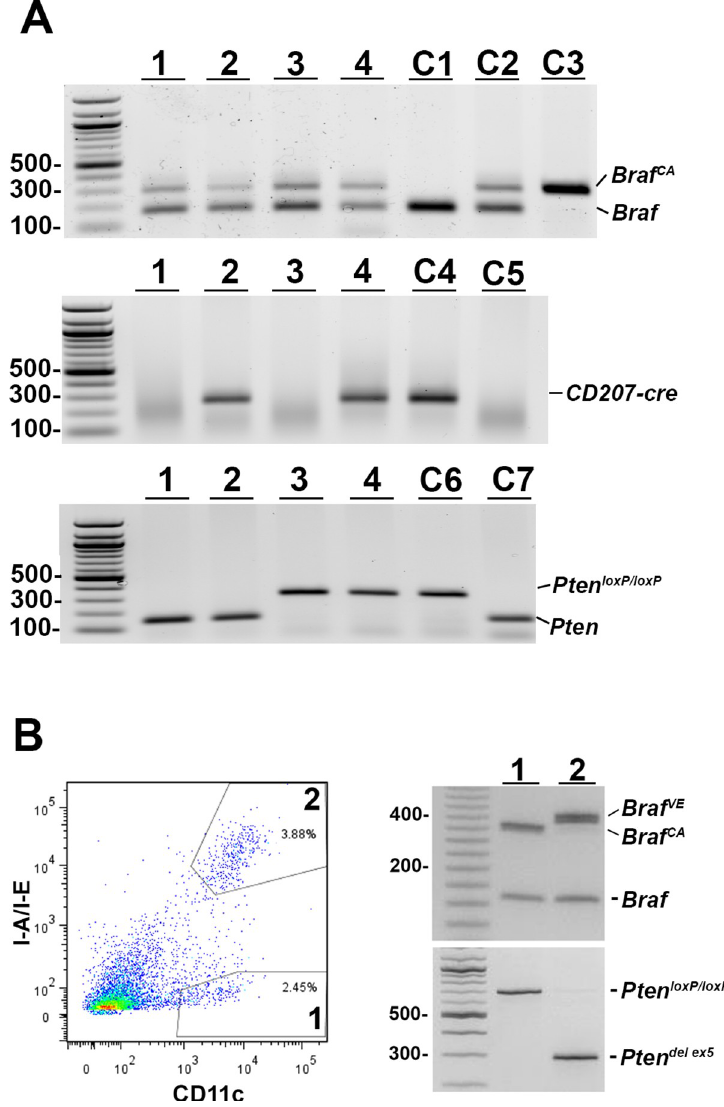
Fig 9. Presence and rearrangement of Braf and Pten alleles in Braf CA Pten loxP/loxP Tg(CD207-cre) mice. A. Presence of non-rearranged alleles in tail-cut DNA of Braf CA Pten loxP/loxP Tg(CD207-cre) mice. Top panel, DNA was extracted from tails of mice numbered 1–4 and analyzed by PCR for the presence of wild type Braf (product size 185 bp), non- rearranged Braf CA (308 bp), and Braf VE (335 bp). Only the wild type and non-rearranged alleles are detectable in bulk DNA. C1, C2, and C3 are control DNAs from mice homozygous for wild type Braf , mice heterozygous for wild type Braf and Braf CA , and mice homozygous for Braf CA , respectively. Middle panel, DNA from the tails of mice 1–4 was analyzed for the presence of the CD207-cre allele. The expected product of 272 bp was observed in mice 2 and 4. C4 and C5 are control DNAs from mice known to carry the CD207-cre allele, and wild type mice, respectively. Bottom panel, DNA from the tails of mice 1–4 was analyzed for the presence of the Pten loxP/loxP allele. The expected product of 328 bp was observed in mice 3 and 4, and the PCR product of 156 bp derived from the wild type Pten allele was observed in mice 1 and 2. C6 and C7 are control DNAs from mice known to carry the Pten loxP/loxP allele, and wild type mice, respectively. B. Rearranged Braf and Pten alleles in epidermal LCs of Braf CA Pten loxP/loxP Tg(CD207-cre) mice. Cells were isolated from the epidermis of a 47-day-old Braf CA Pten loxP/loxP Tg(CD207-cre) mouse as described in Materials and Methods and sorted into I-A/I-E - /CD11c + (1) and I-A/I-E + /CD11c + (2) populations (left panel). DNA was extracted from each cell population and analyzed by PCR for the presence of BRAF and Pten alleles. The LCs (population 1) showed rearranged BRAF VE and Pten del ex5 alleles which were absent from the non-LC cells (population 2).